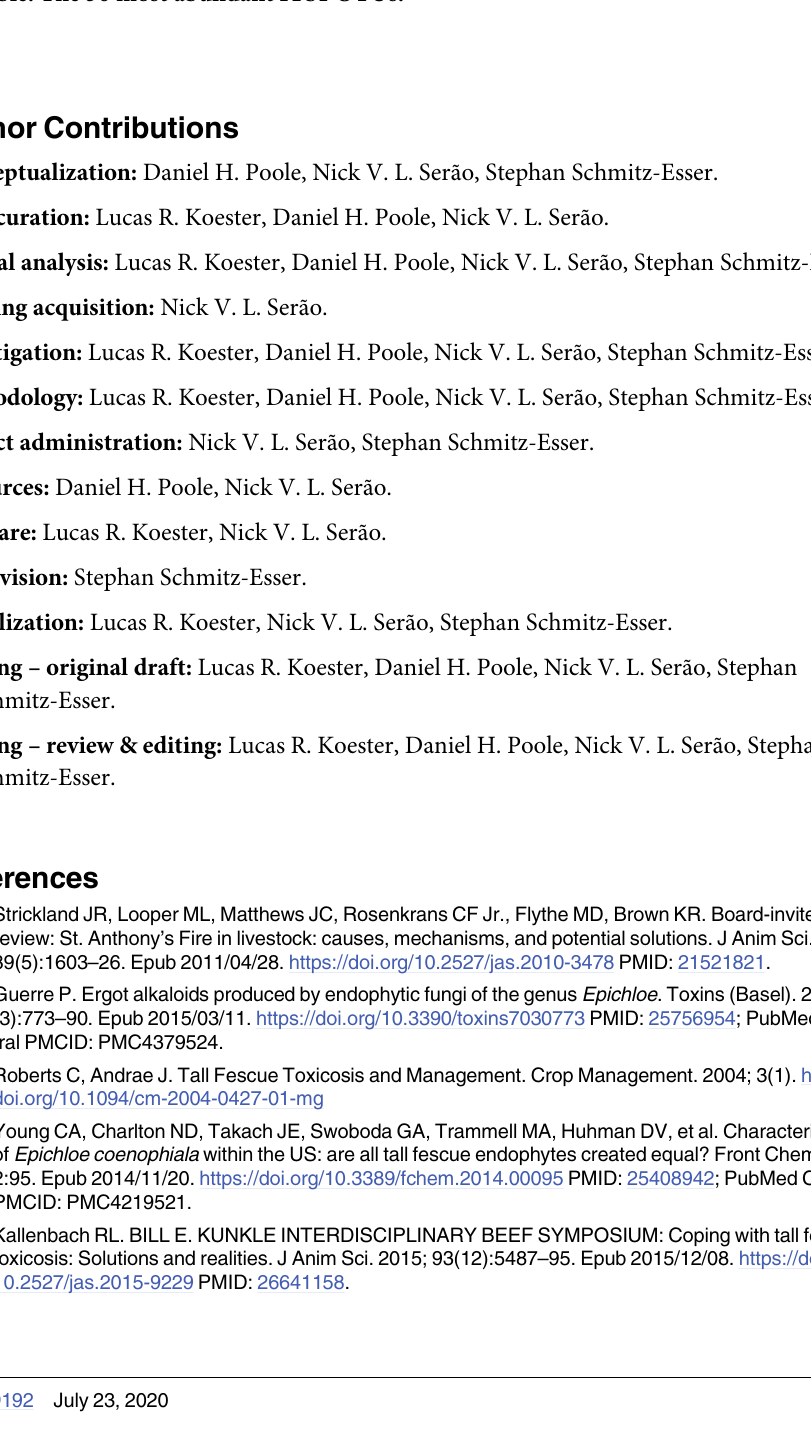
S3 Table. Residual variance ( σ _e^2)1 for each window period (WP), and AWG_res2 means for each WP by genetic group (GG). S4 Table. The 50 most abundant 16S rRNA gene OTUs. S5 Table. The 50 most abundant ITS1